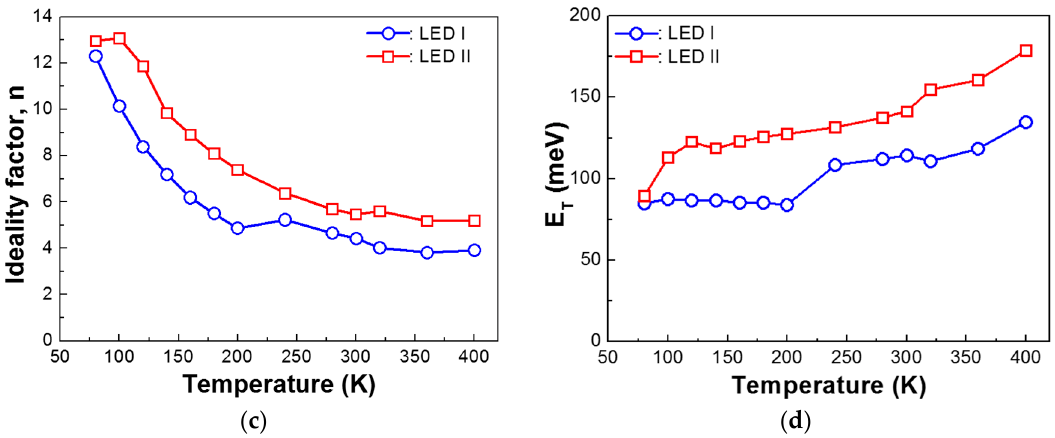
Figure 2. Ideality factor n and corresponding characteristic energy E T of the InGaN/GaN LEDs in the range of ( a , b ) low and ( c , d ) intermediate forward bias. Blue and red colors indicate LED I and LED II, respectively. The obtained values are deduced from Equations (1) and (2).